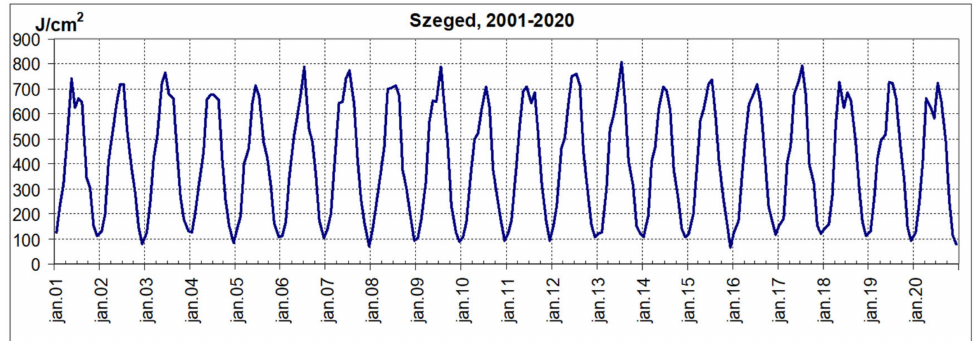
Figure 2. Homogenized monthly amounts of global radiation